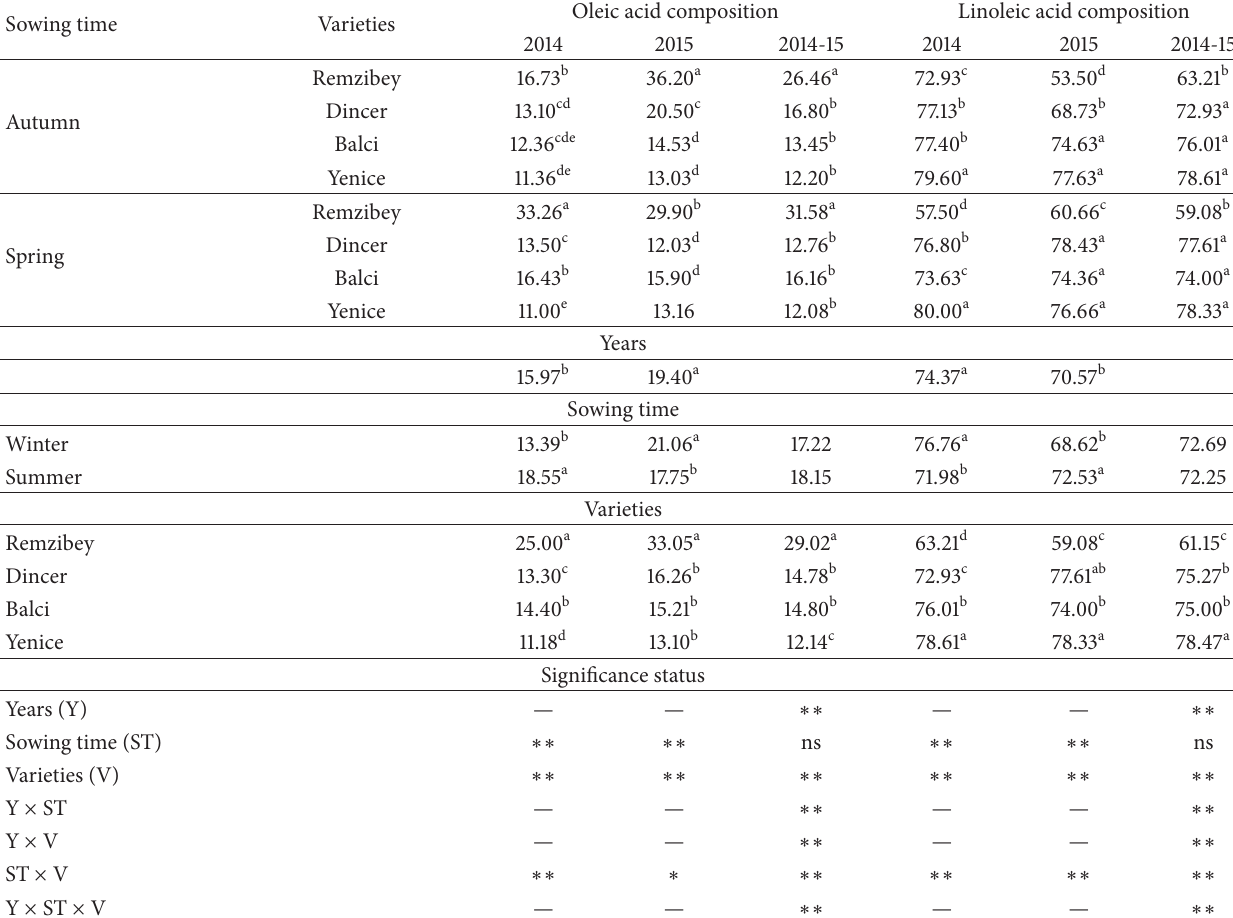
Table 3: Oleic and linoleic acid composition of safflower seeds sown in the autumn and spring. Sowing time